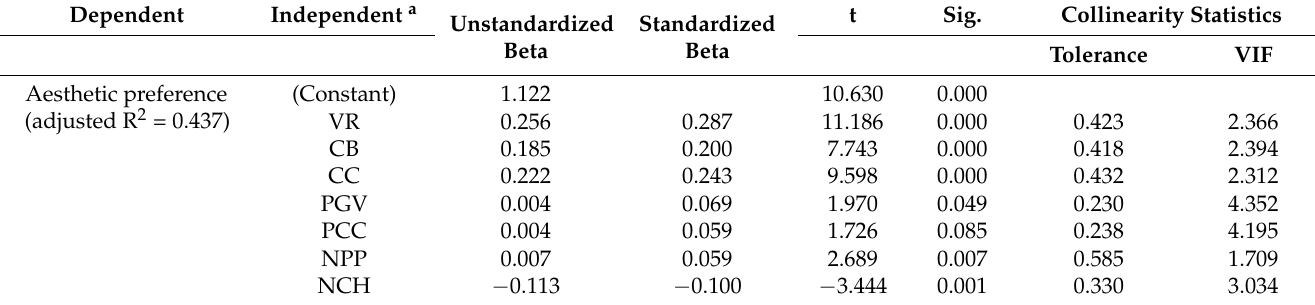
Table 5. Significant predictors for the aesthetic preference emerging from backward multiple linear regression analysis.